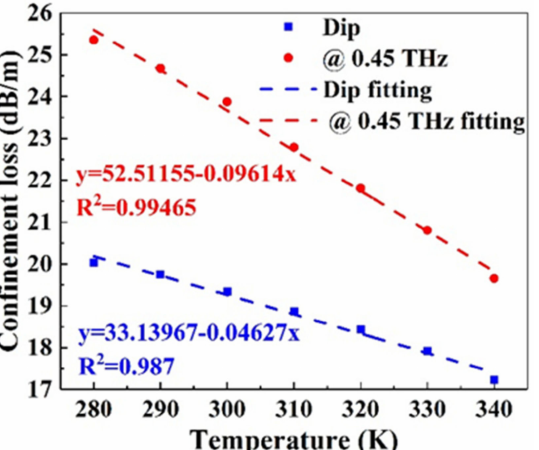
Figure 8. Temperature dependence of the confinement loss at the dip and at 0.45